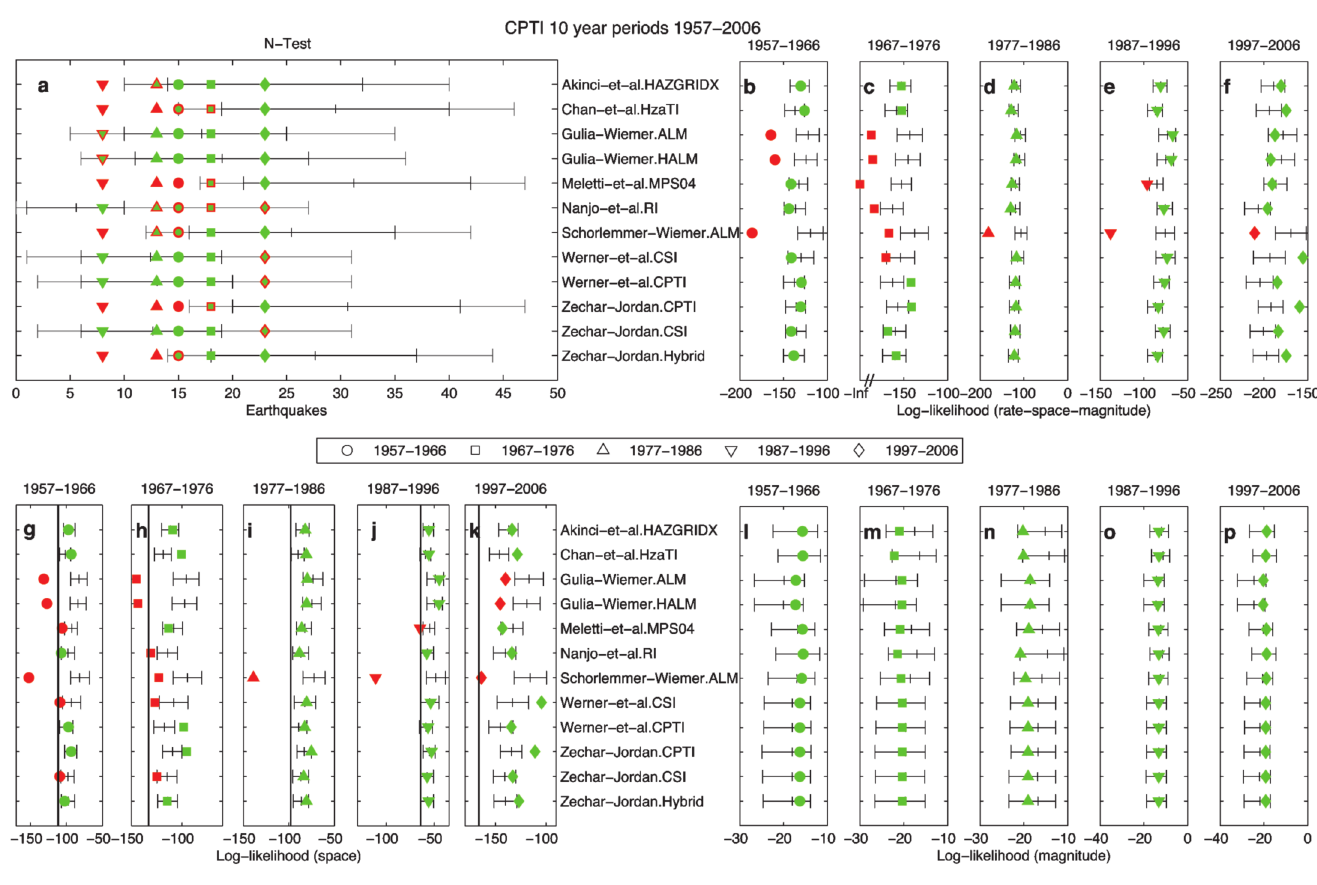
Figure 4. Results of the (a) N-Test, (b-f) conditional L-Test, (g-k) S-Test, and (l-p) M-Test of the 10-year time-independent forecasts using five separate 10- year target periods of data from the CPTI. Symbols and bars as given in the legend to Figure